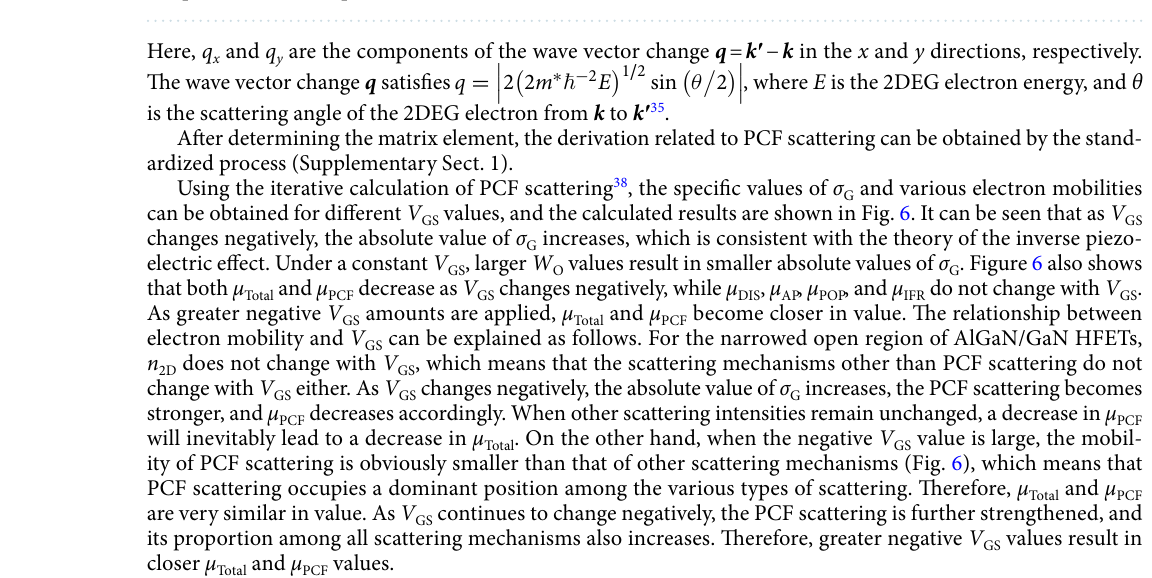
Figure 5. The measured gate leakage current as a function of the gate bias: ( a ) sample 1, ( b ) sample 2, ( c ) sample 3, and ( d ) sample